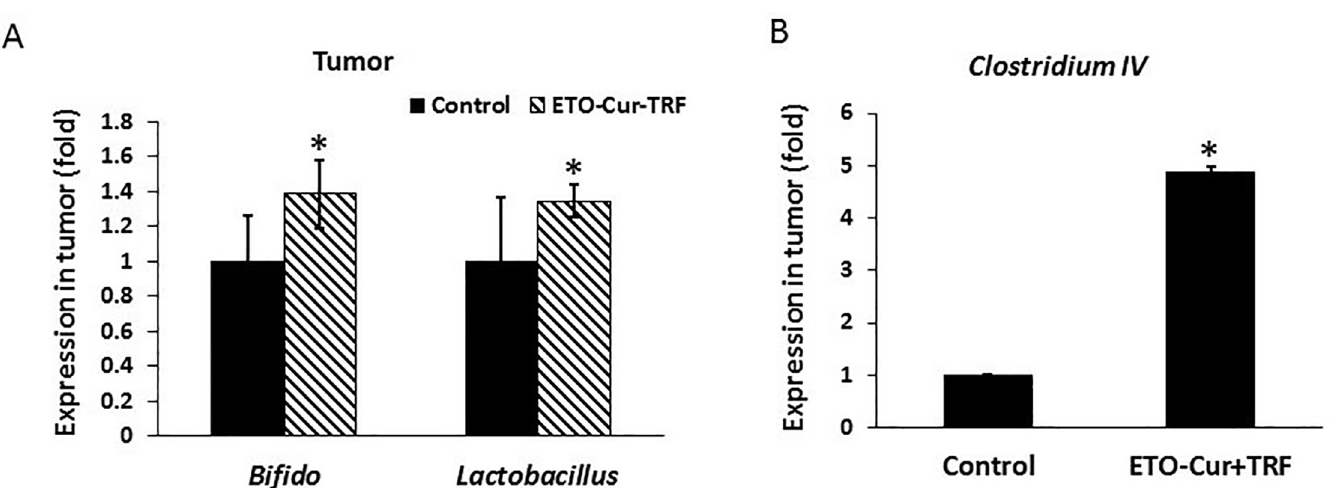
Fig 6. Changes in the relative abundance of (A) Bifidobacteria and Lactobacillus and (B) Clostridium IV in the xenograft of SCID mice 34 days following administration of Cur-ETO-TRF or vehicle (controls) as determined by qPCR (50 ng DNA/sample) with specific primers and each sample ΔΔ CT values were calculated by normalizing to the CT value of total Eubacteria. Bars represent mean of three reading standard deviation; � p < 0.01, compared to the corresponding control.